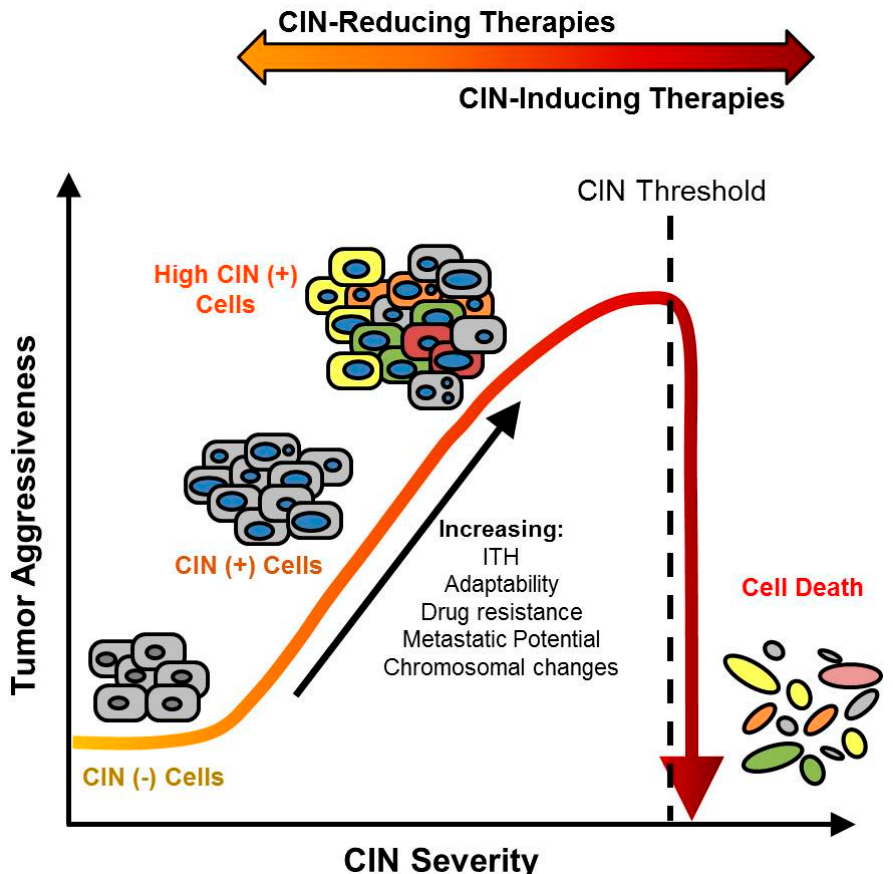
Figure 1. Therapeutic Strategies to Exploit Chromosome Instability (CIN) in Cancer. Schematic presenting the relationship between increasing CIN and key tumor features (e.g., adaptability, intratumoral heterogeneity (ITH), drug resistance, metastatic potential and chromosomal changes). Two alternative therapeutic strategies that exploit CIN are presented (arrow, top). (1) CIN-reducing treatment strategies suppress CIN in CIN+ tumors to slow and/or prevent acquisition of additional chromosomal alterations. Ideally, this will hinder tumor adaptability, cancer cell evolution, and the acquisition of drug resistance, thereby reducing tumor aggressiveness; (2) Alternatively, CIN-inducing strategies seek to generate extensive levels of numerical and/or structural CIN beyond a critical threshold (black dotted line) to induce cell death. +: positive; − : negative.